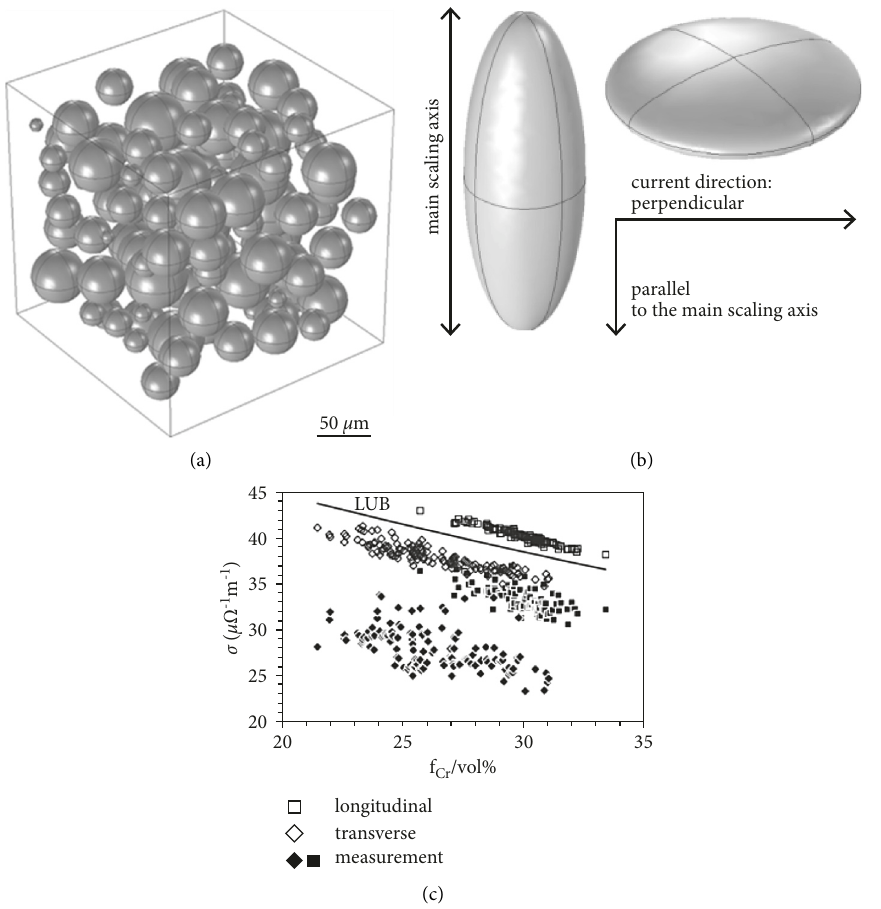
Figure 6: Conductivity simulation model. (a) Spherical second-phase particles; (b) needlelike and flaky particles generated by scaling particles from (a); and (c) the measured values